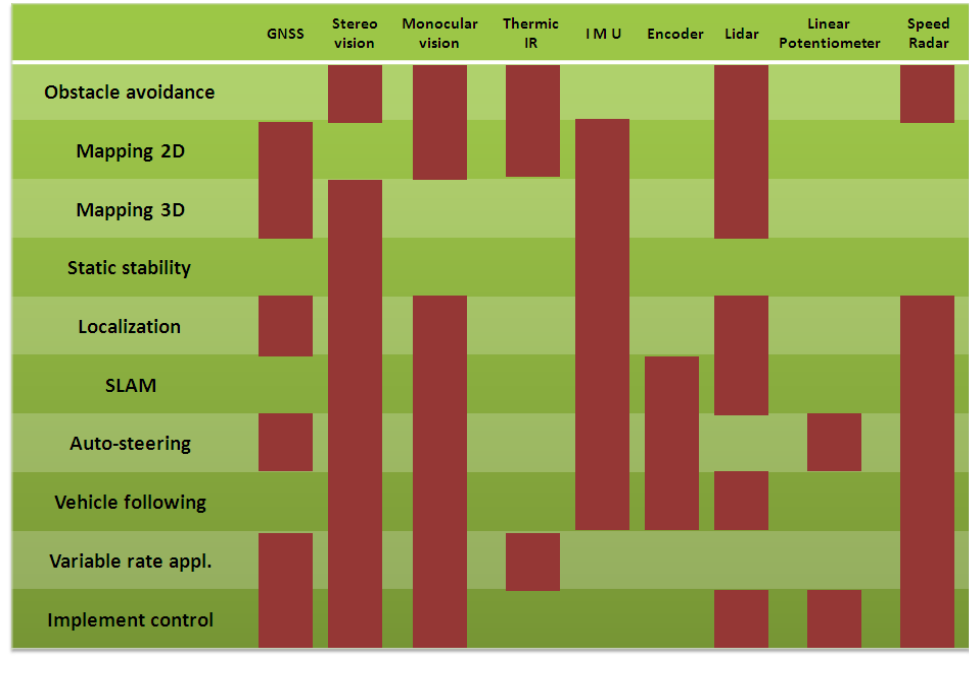
Table 1. Sensor-task cross